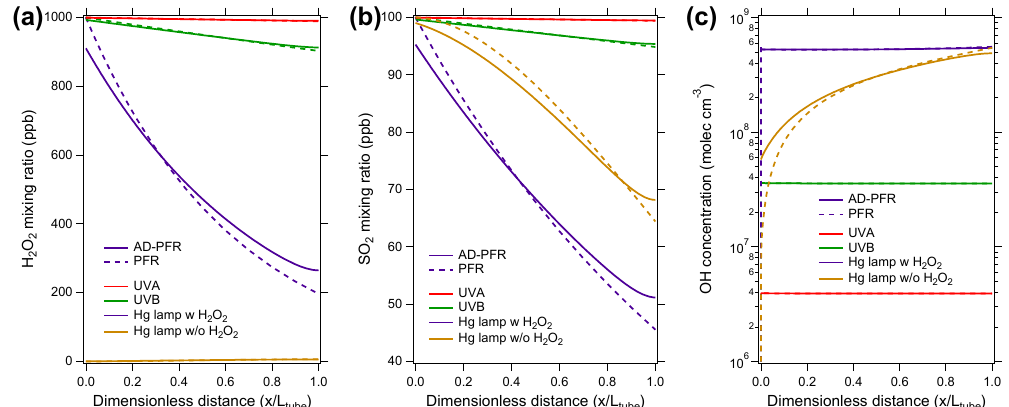
Figure 14. One-dimensional photochemical model using axially dispersed assumption (AD-PFR, solid line) and plug flow assumption (PFR, dashed line). In the simulation, 1ppm H 2 O 2 and 100ppb SO 2 at RH = 5% and T = 295K is used. Hg vapor (purple), UVB (green) and UVA (red) lamps at full emission are used to drive the photochemical reactions. (a) Axial profile of H 2 O 2 , (b) axial profile of SO 2 and (c) axial profile of